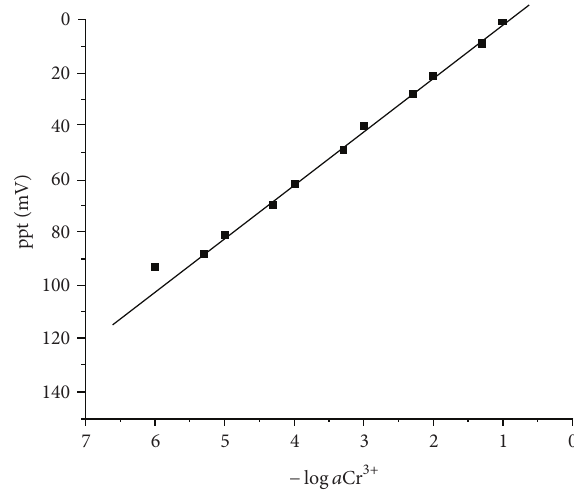
F 1: Potentiometric response of the PVC membrane sensor based on